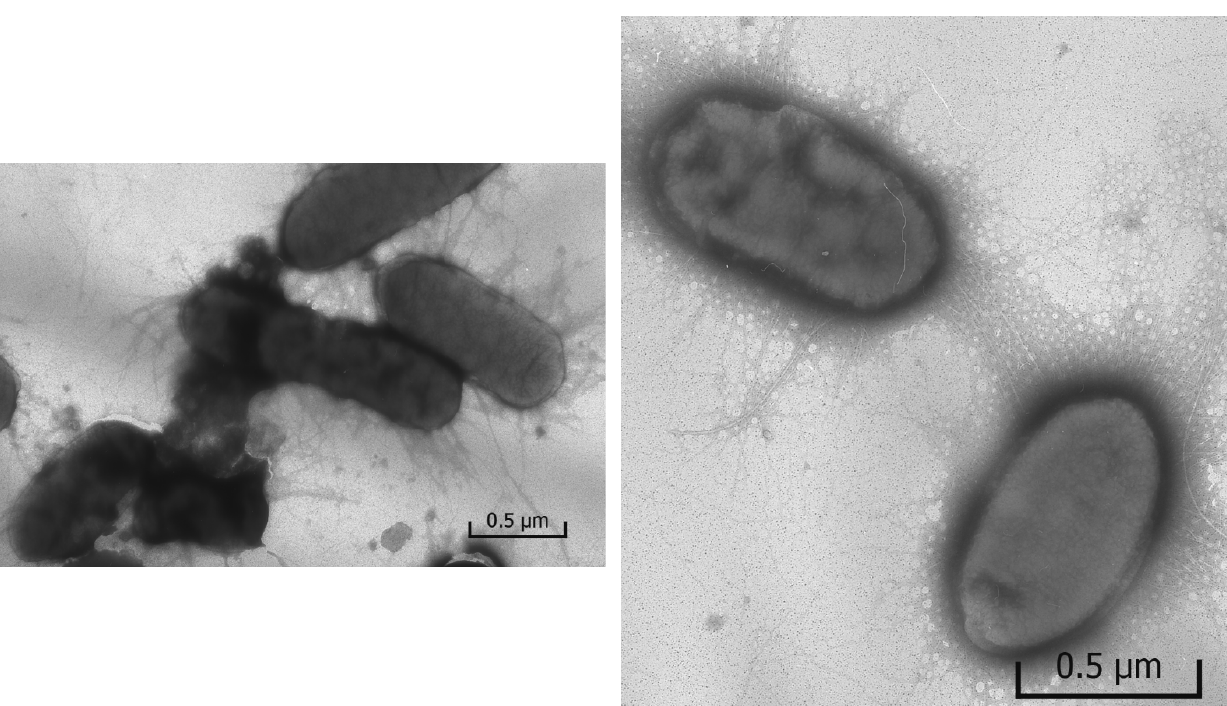
Figure 9. Photomicrographs of Escherichia coli grown in the presence of Ag-Ag 2 O-NPs (20 nm) (1 × 10 − 5 mol L − 1